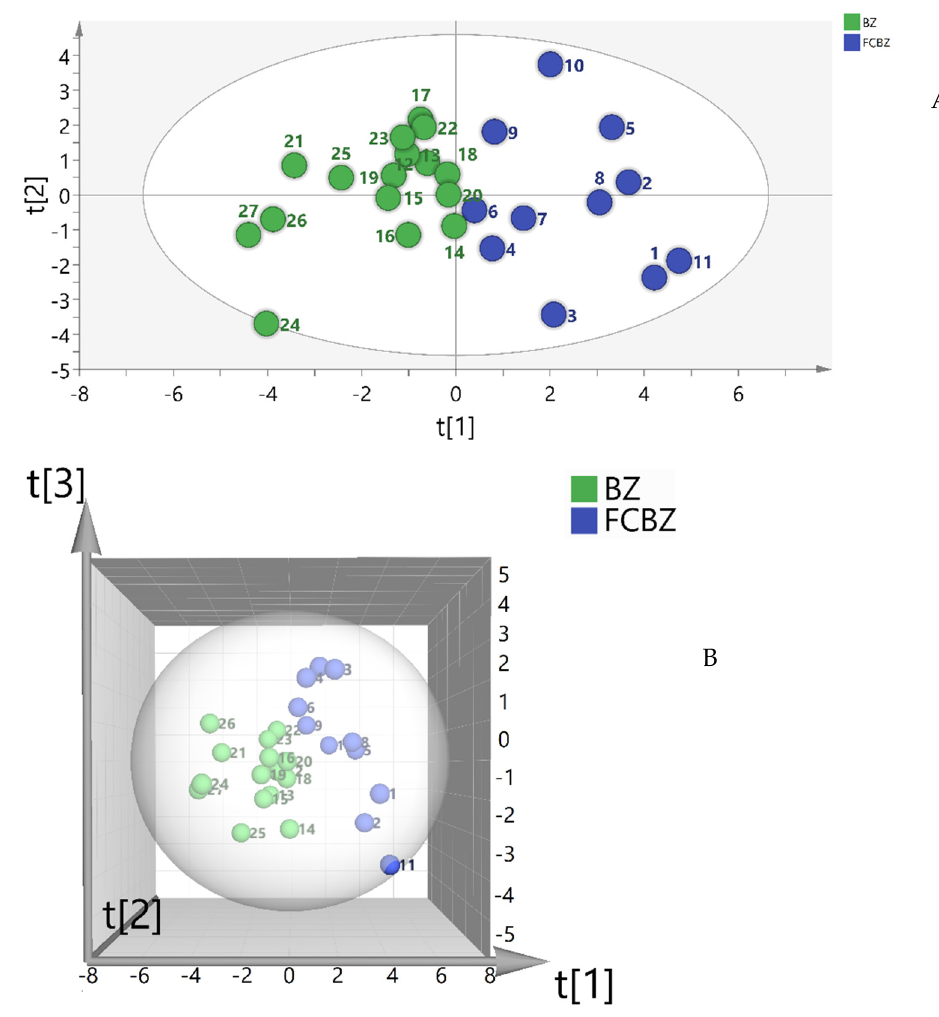
Figure 4. Principal component load diagram. ( A ) PCA score chart; ( B ) PCA-3D score chart.